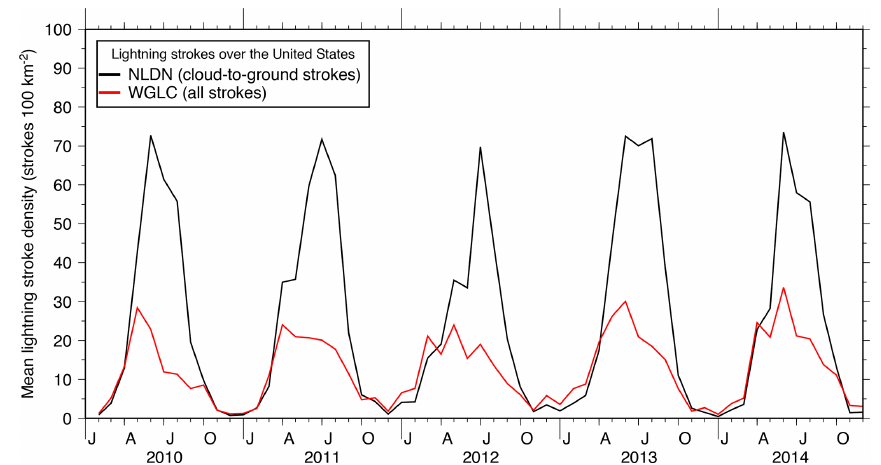
Figure 14. Time series of monthly mean lightning density of NLDN (black line) and WGLC (red line) over the conterminous United States.